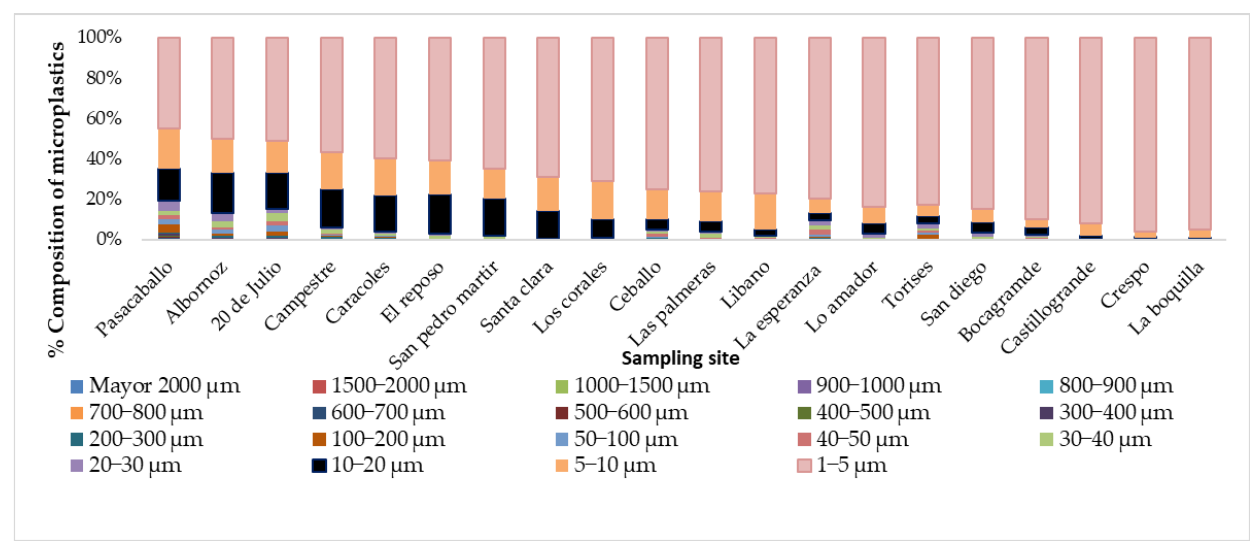
Figure 2. Distribution of the size of the MPs in the different neighborhoods. Table 1. Values of morphological parameters for the MPs